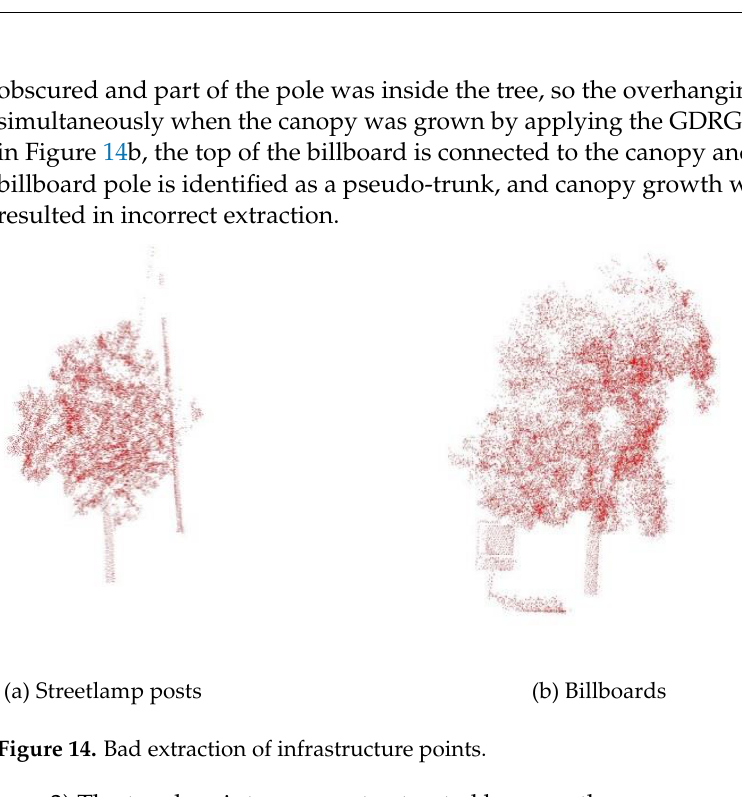
Figure 13. Accuracy errors by trees near buildings.